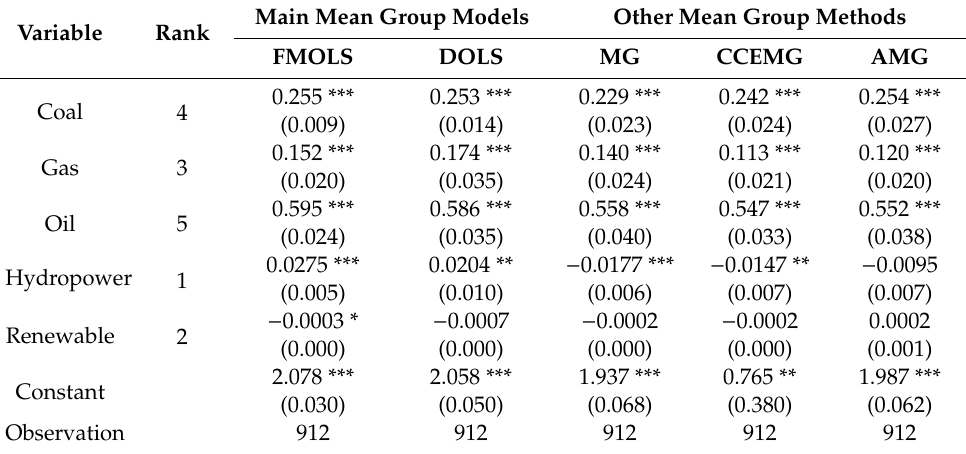
Table 8. Robustness check for model 1 by excluding the income